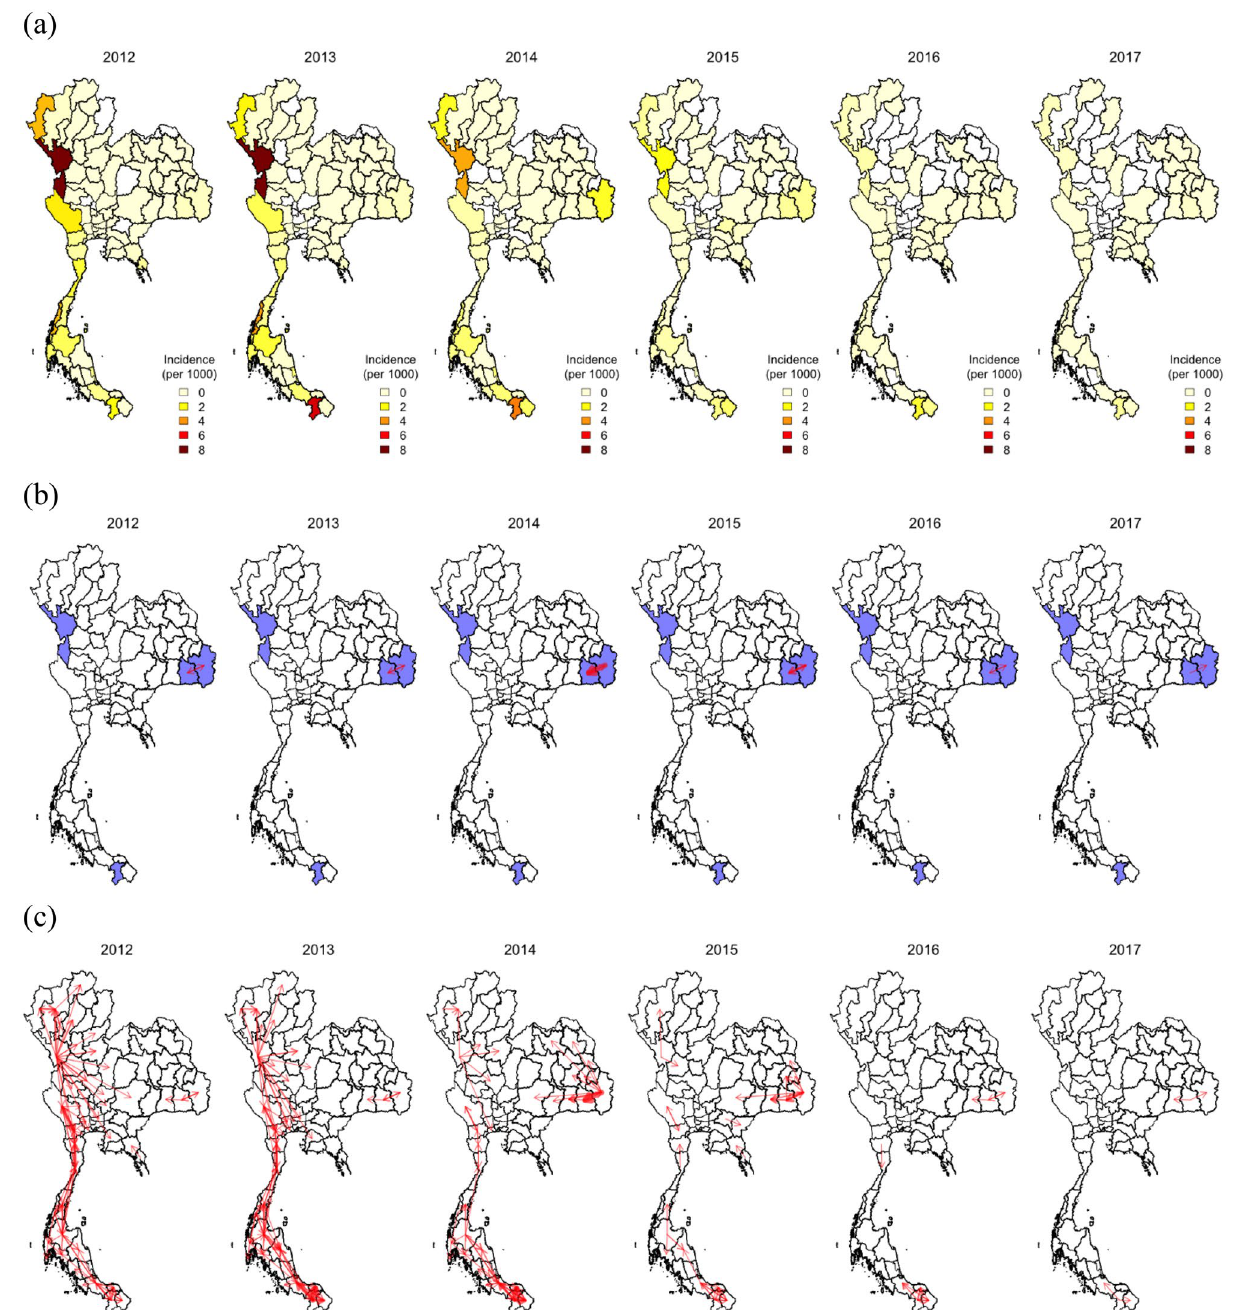
Figure 1. Spatial and temporal case data and estimated parasite flow. ( a ) Spatial distribution of malaria case data from 2012 to 2017. ( b ) Parasite flow among three malaria endemic regions in Thailand (Ubon Ratchathani parasite flow greater than 1 was